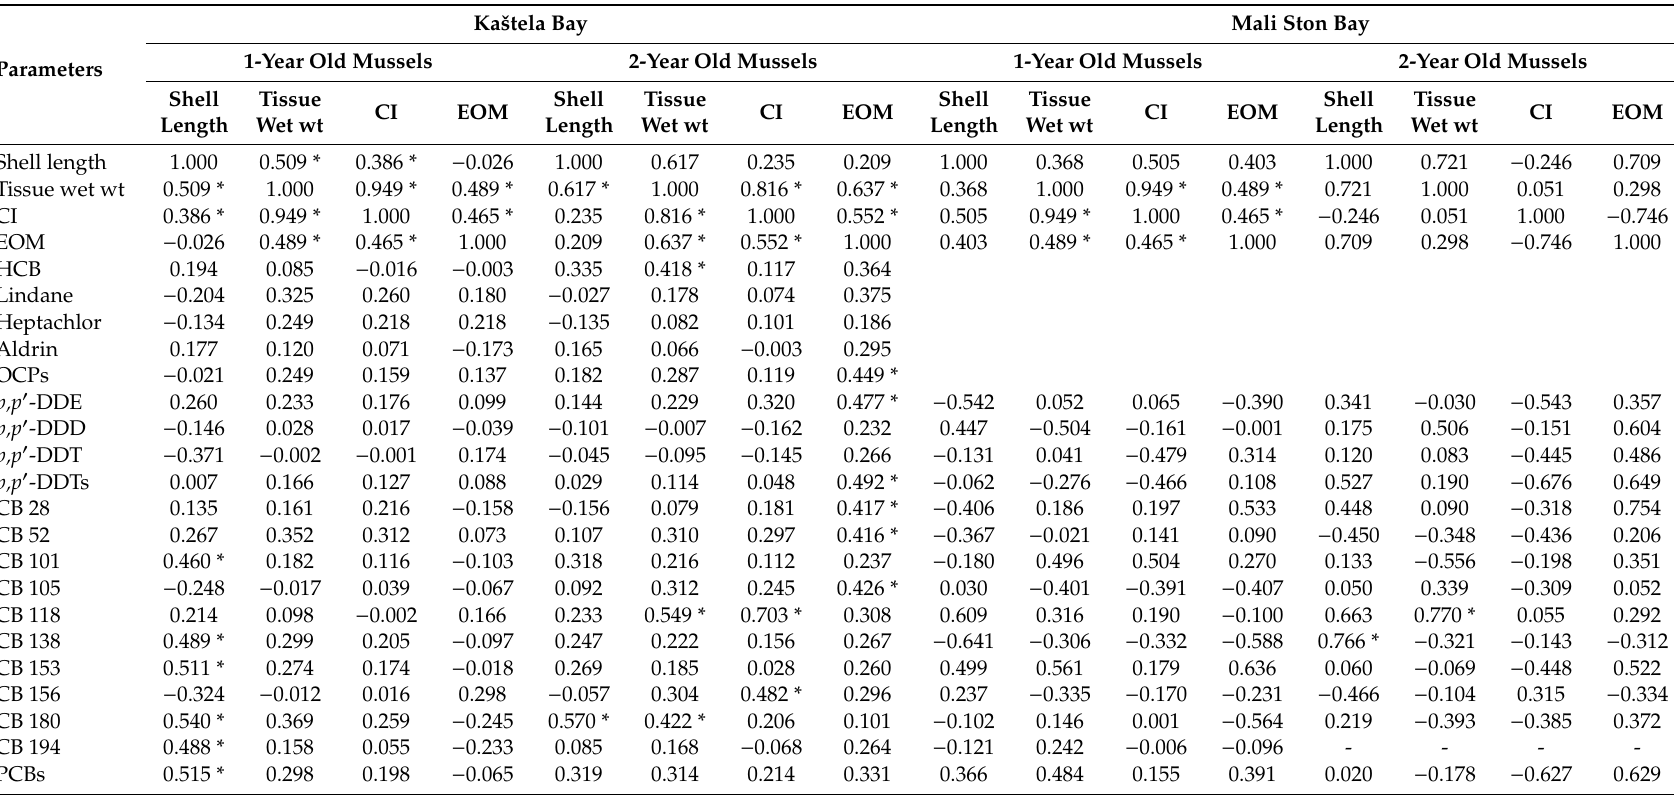
Table 2. Pearson’s product-moment correlation coe ffi cients between biological parameters and OC content in 1- and 2-year-old mussels in Mali Ston Bay and the ones transplanted to Kaštela Bay. * Significant at p <